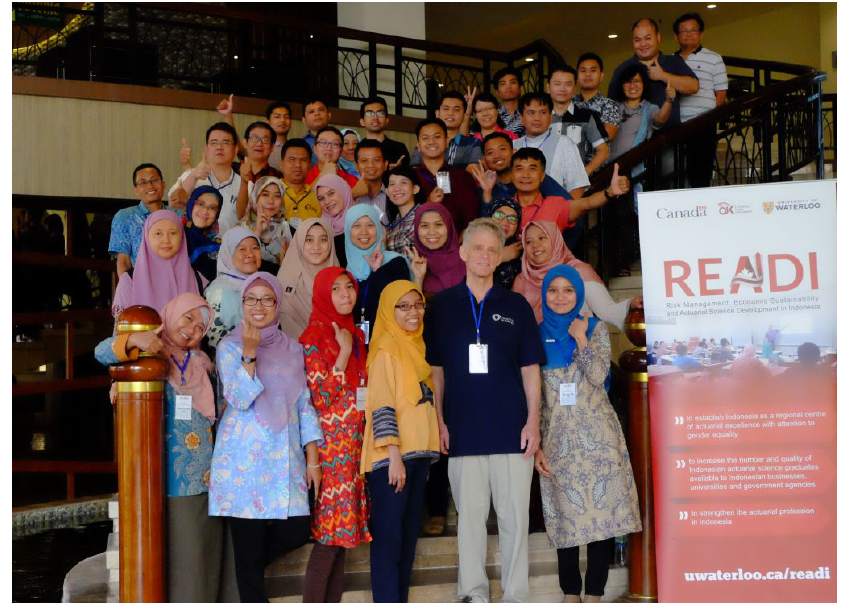
Figure 5: Teaching a short course at READI (Risk Management, Economic Sustainability and Actuarial Science Development in Indonesia), 2018, in Belitung, Indonesia. Pictured here are Jed with short course students who are actuarial faculty in Indone-